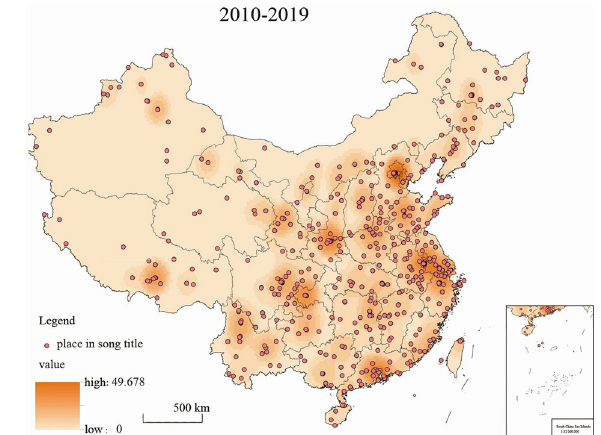
Fig. 5 Kernel density estimation of place in music in 2010 – 2019. Kernel density estimation of place in music titles from 2010 to 2019 indicates that the darker areas are distributed primarily in Beijing – Tianjin – Hebei Urban Agglomeration, Yangtze River Delta, Shaanxi, Sichuan, and the Chongqing region. These places are referred to often in song titles, forming a cluster. Table 5 Keywords of sense of place: 2010 – 2019. Key words TF-IDF Key words TF-IDF Key